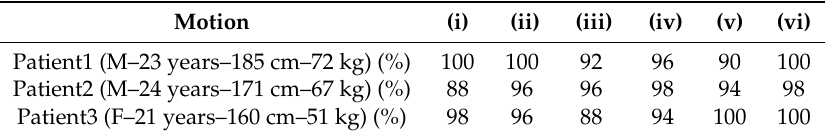
Figure 9. Snapshots of the computer screen showing the estimated patient postures and signal processed values from the sensor outputs at the transition ( a ) from the standing to sitting position (i); ( b ) from the sitting to standing position (ii); ( c ) from the sitting to sitting knee extension position (iii); ( d ) from the sitting knee extension to sitting position (iv); ( e ) from the sitting knee extension to supine position (v); and ( f ) from the supine to sitting knee extension position (vi). The arrows are added to represent the transitions from the previous positions. Table 1. Success rate of the patient posture monitoring